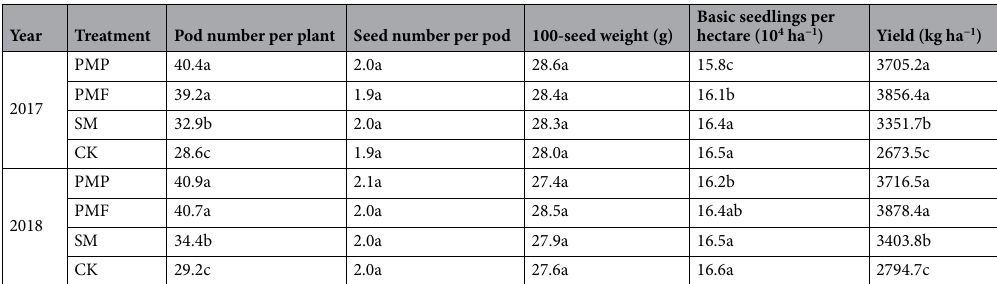
Table 4. Grain yield and yield components under different cultivation practices in Hesheng Town of Gansu Province, China, in 2017 and 2018. Different letters within columns indicate significant differences (P < 0.05) according to the LSD test.